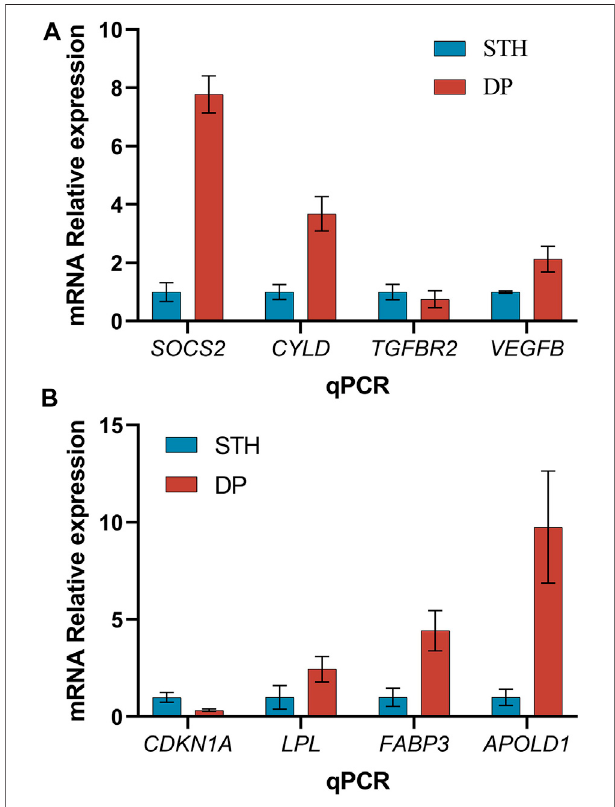
FIGURE 4 | Quantitative real time PCR analysis (mean ± s.d., n = 3 biological replicates). (A) Results of 4 DEGs of liver; (B) Results of 4 DEGs of